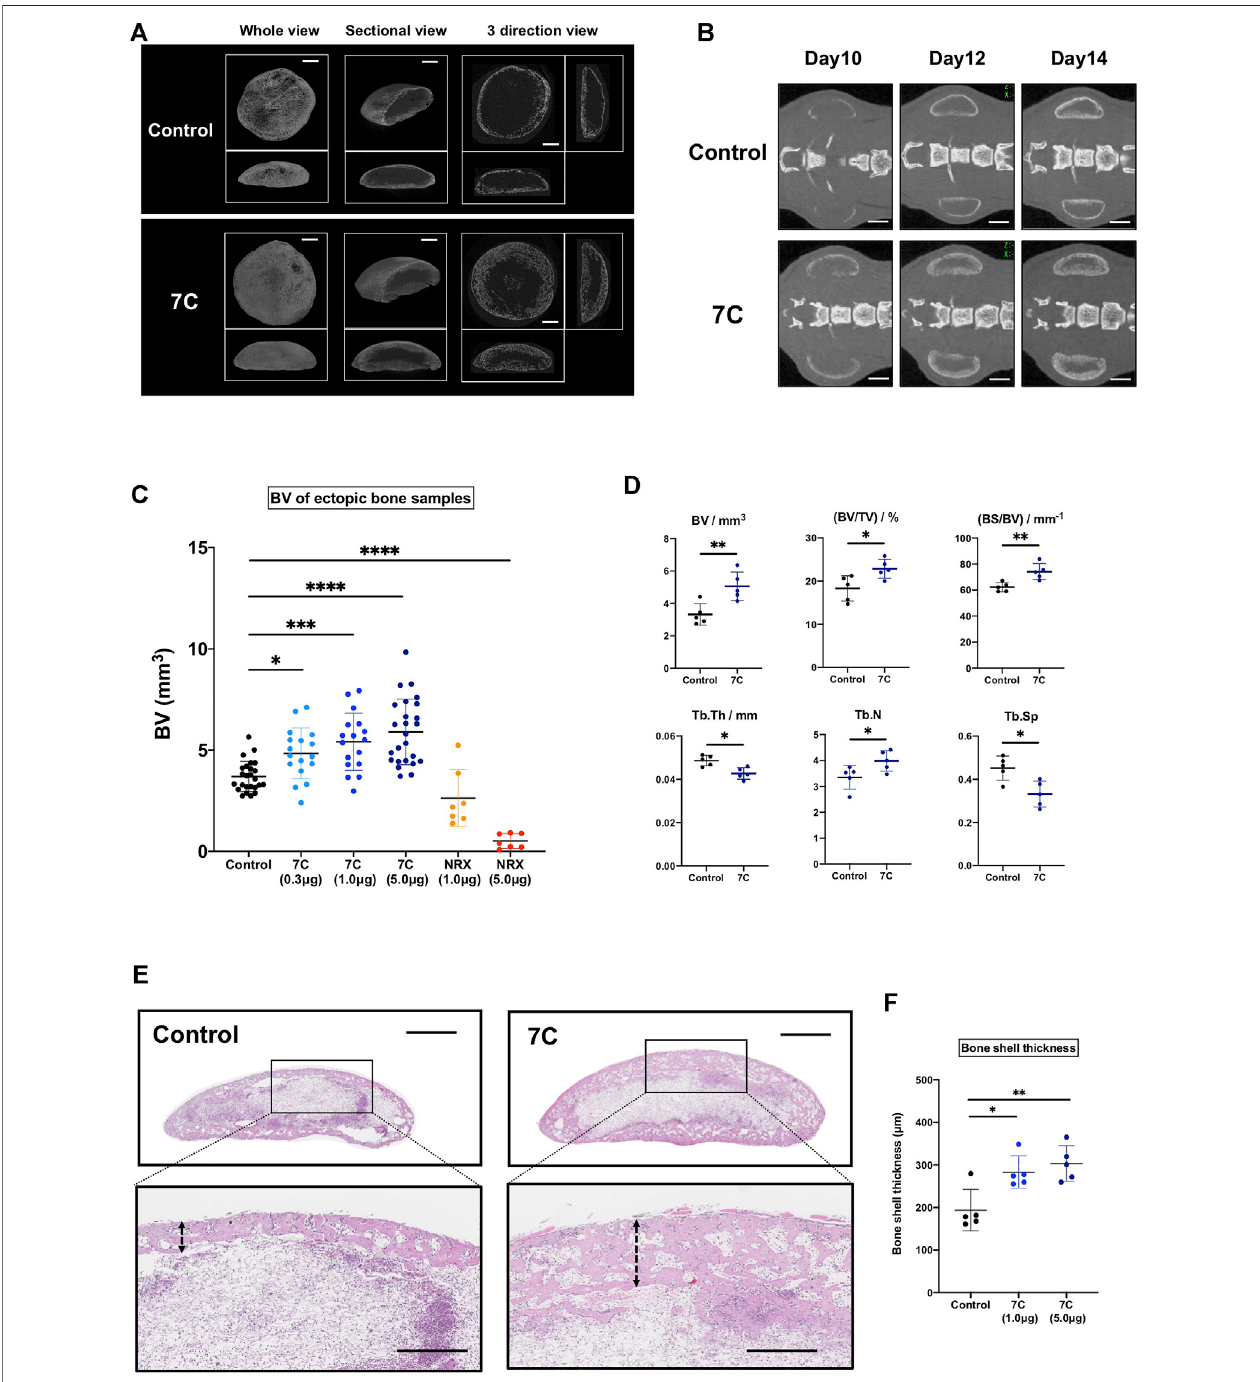
FIGURE2| AnalysisofboneinducedintheBMP-2pellets onDay14. (A) Exvivo 3Dmicro-CT images oftheectopic bone (scalebar =1 mm). (B) Invivo micro-CT imagesofectopicbones(scalebar=2 mm). (C) TheBVoftheectopicboneinthe7CandNRXgroups.TheBVwassigni fi cantlyhigherinthe7Cgroupsandlowerinthe NRX groups ina dose-dependent manner compared to the control value (control; n =25, 7C-0.3; n = 17, 7C-1.0; n = 17,7C-5.0; n =25, NRX-1.0; n = 7,and NRX-5.0; n =7;* p < 0.05,*** p < 0.001,and**** p < 0.0001). (D) Comparisonofmicrostructuralboneparametersbetweenthecontroland7Cgroups. n =5,*p < 0.05,and**p < 0.01. (E) Histologicalsections(H&Estaining)ofBMP-2pellets(wholeview,scalebar=1 mm;magni fi edview,scalebar=400 μ m).7Cgroupformedthickerboneshell. (F) Comparison of bone shell thickness. n = 5, * p < 0.05 and ** p < 0.01.